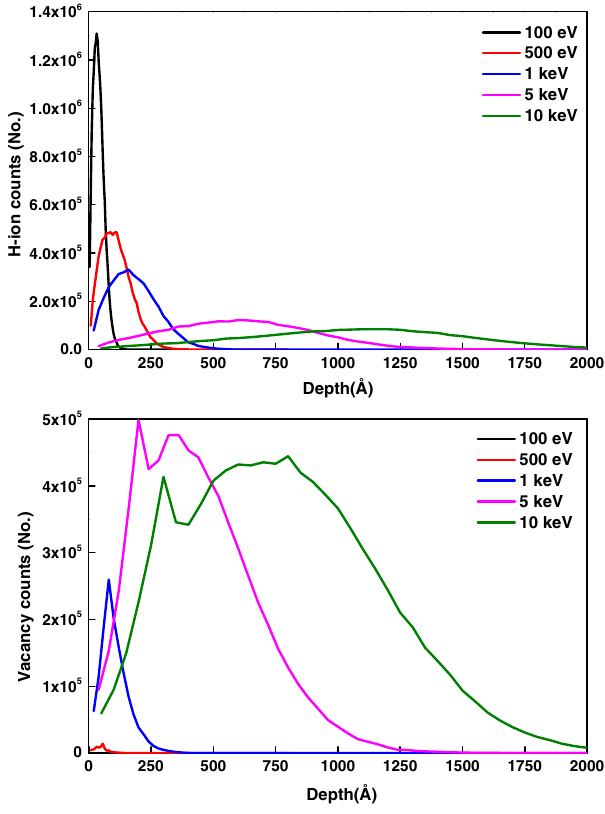
FIG. 3. (top) Hydrogen ion distribution and (bottom) vacancy distribution within GaAs for different hydrogen ion energies. All simulations performed using the same hydrogen ion dose of 8 . 1 × 10 5 nA s. Plots were obtained using SRIM